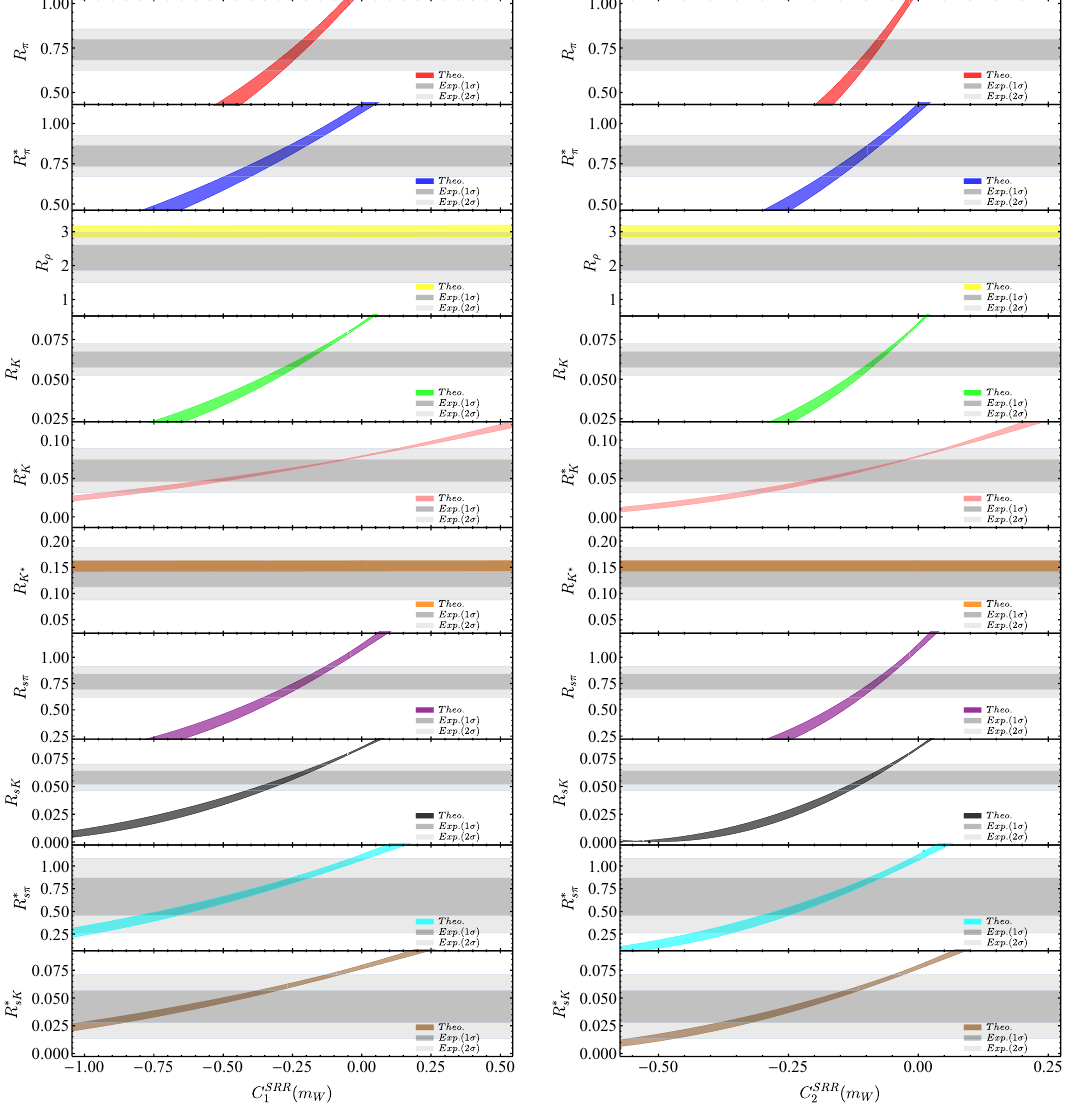
( m W ) (left) and C SRR ( m W ) 1 2